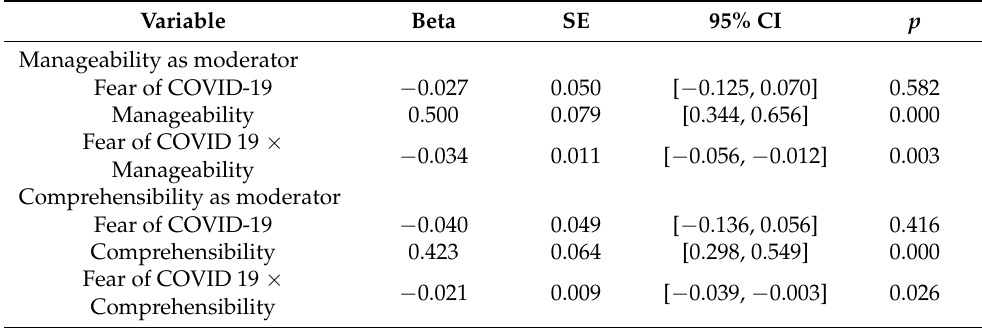
Table 4. Moderation analysis of the role that comprehensibility and manageability play in the relationship between fear of COVID-19 and personal